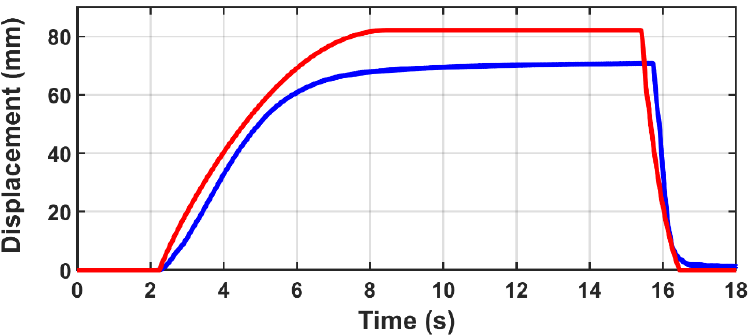
Figure 17. Dynamic responses of the actuator: red line — theoretical results; blue line — experimental results for m = 5.0 kg.